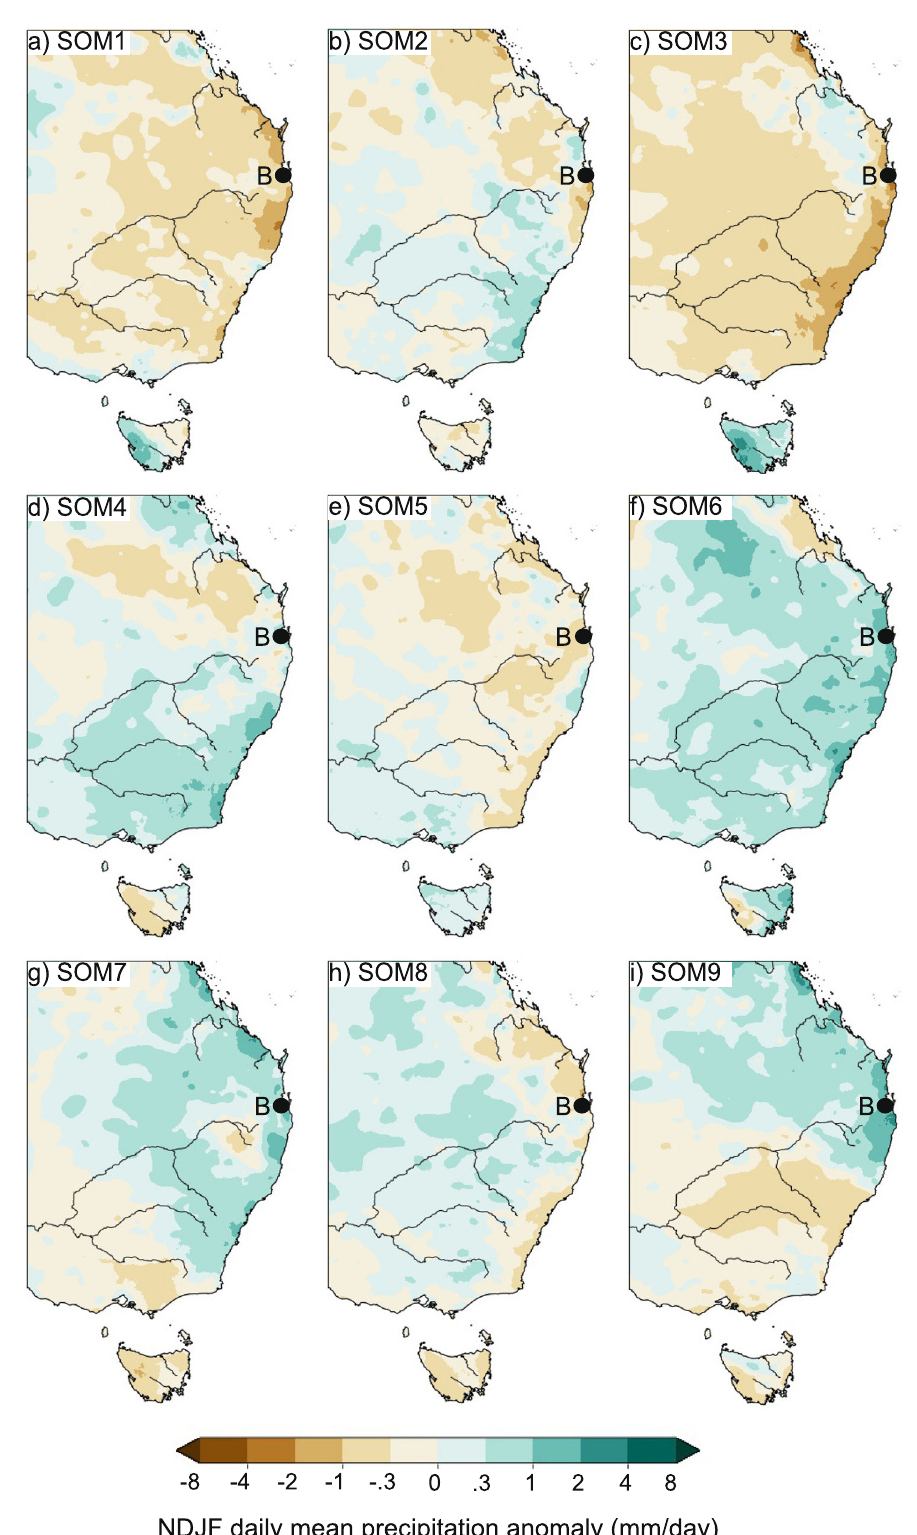
Fig. 3 NDJF daily mean rainfall anomaly (dataset: AGCD v1 65 ) over eastern Australia for each SOM node from ref. 33 over 1979/80 to 2017/18. SOM nodes 1 to 9 are labelled ( a – i ). B = Brisbane. Note the precipitation scale is non-linear.